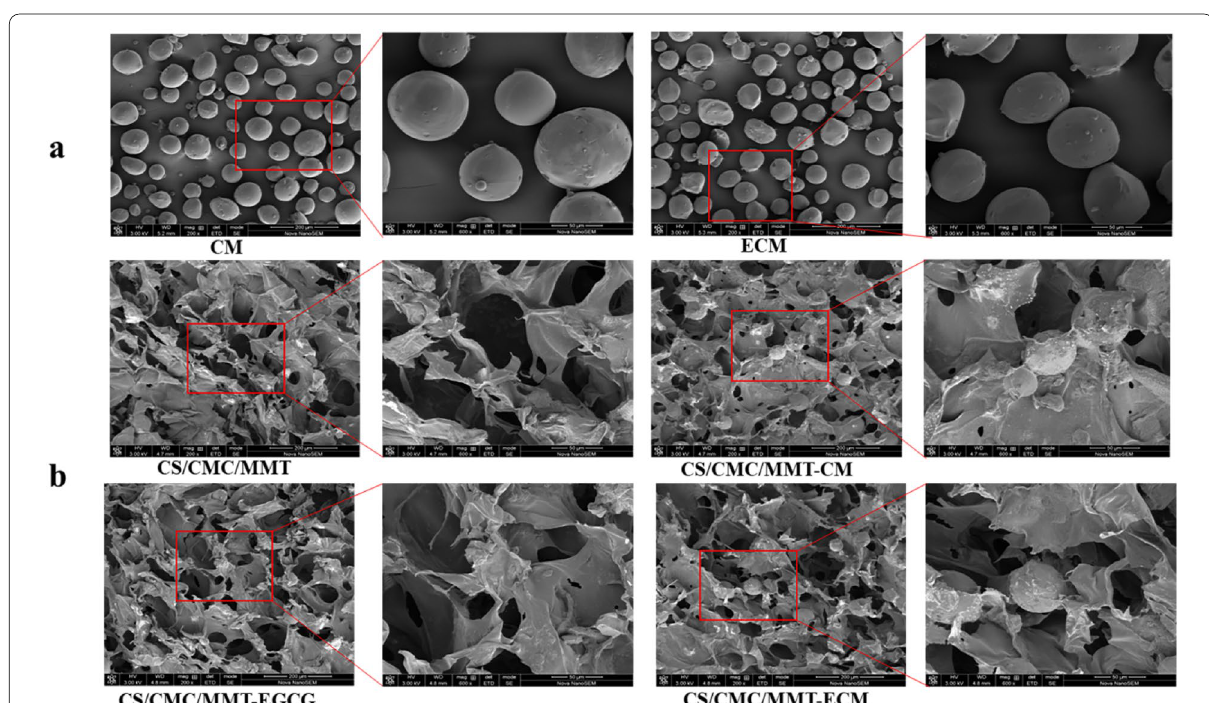
Fig. 5 a SEM images of CM and ECM. b SEM images of CS/CMC/MMT, CS/CMC/MMT‑CM, CS/CMC/MMT‑EGCG and CS/CMC/MMT‑ECM scaffolds. The inset shows a SEM image at 200 and 600 × ×